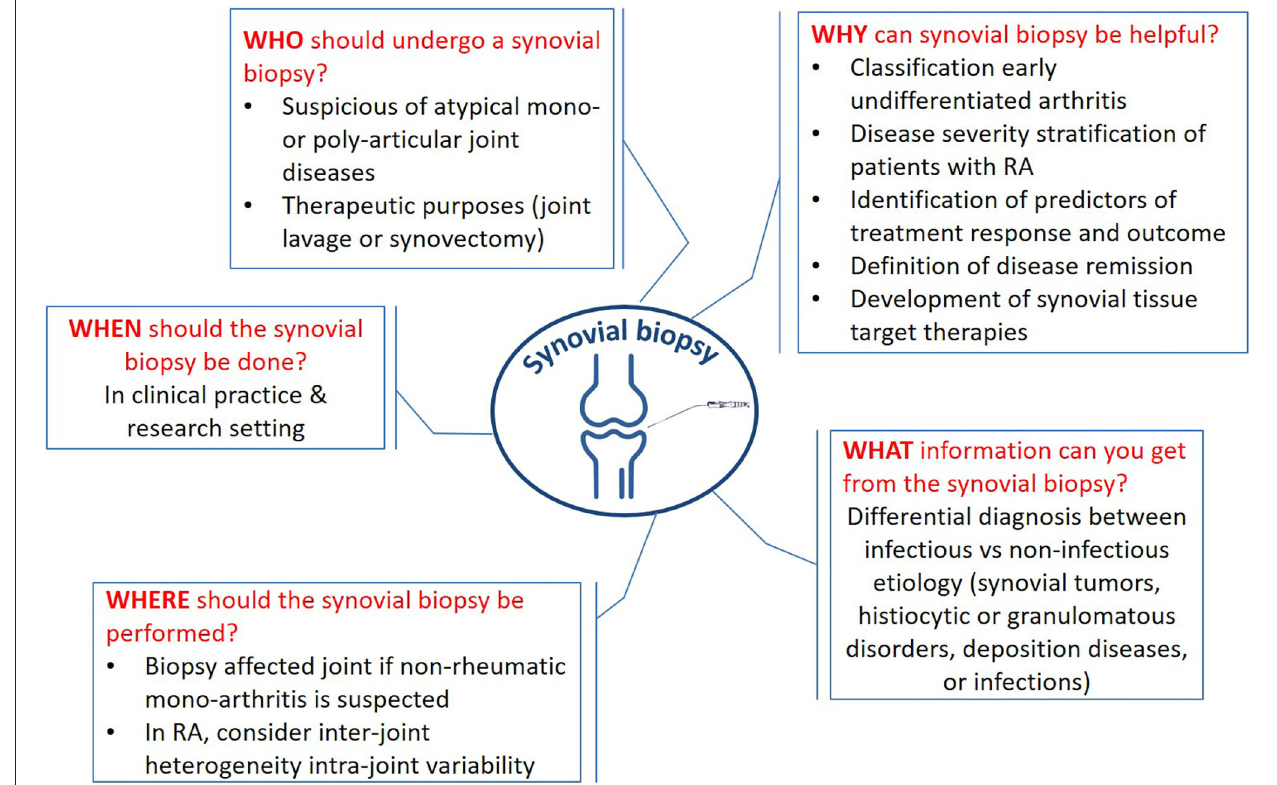
FIGURE 1 | Key messages about the synovial biopsy. The figure sums up the crucial questions (why, when, what, who, where, and how) and the related